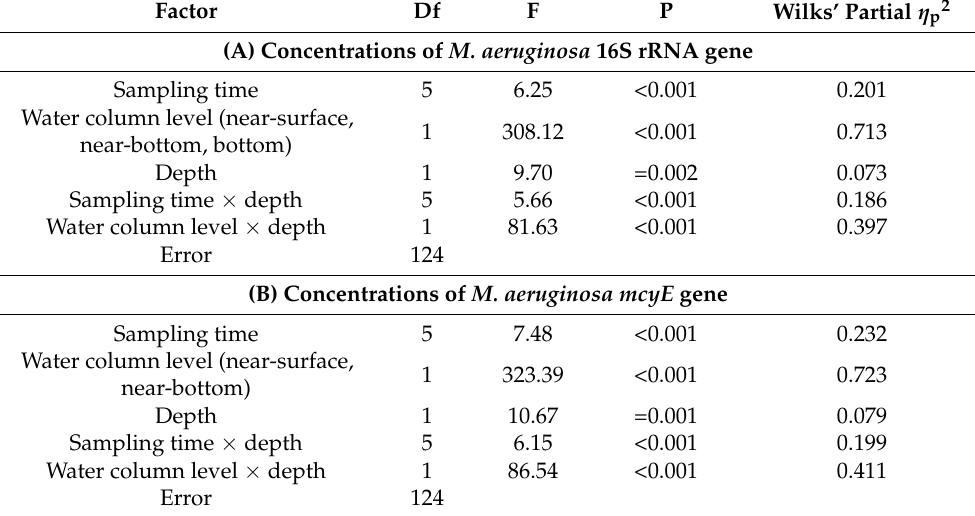
Table 2. Results of a univariate GLM using concentrations of the M. aeruginosa (A) 16S rRNA and (B) mcyE gene as the dependent variable. Df refers to degrees of freedom, F refers to the ratio of population variances, and P indicates significance with an alpha threshold of 0.05. Factor Df F P Wilks’ Partial η p2 (A) Concentrations of M. aeruginosa 16S rRNA gene Sampling time 5 6.25 <0.001 0.201 Water column level (near-surface, 1 308.12 <0.001 0.713 near-bottom, bottom) Depth 1 9.70 =0.002 0.073 Sampling time × depth 5 5.66 <0.001 0.186 Water column level × depth 1 81.63 <0.001 0.397 Error 124 (B) Concentrations of M. aeruginosa mcyE gene Sampling time 5 7.48 <0.001 0.232 Water column level (near-surface, 1 323.39 <0.001 0.723 near-bottom) Depth 1 10.67 =0.001 0.079 Sampling time × depth 5 6.15 <0.001 0.199 Water column level × depth 1 86.54 <0.001 0.411 Error 124 Interaction terms were excluded from the final model if p > 0.05 starting with the highest-level interaction term, but the next hierarchical level of interactions was retained if one term had p < 0.05. (Note that further exclusion of single interaction terms did not alter the results